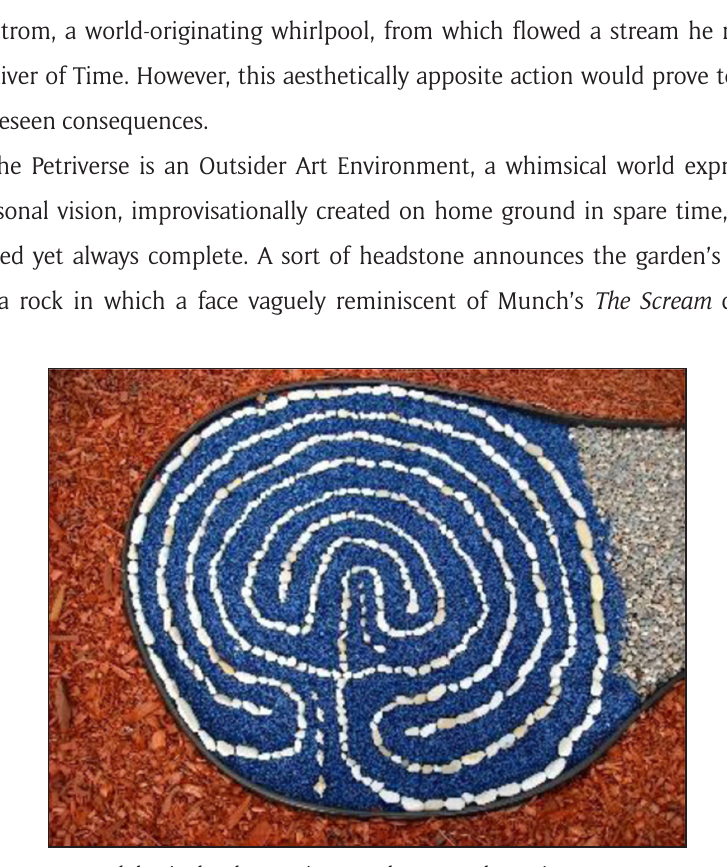
Figure 4: Cretan labyrinth, The Petriverse. Photo: Paul